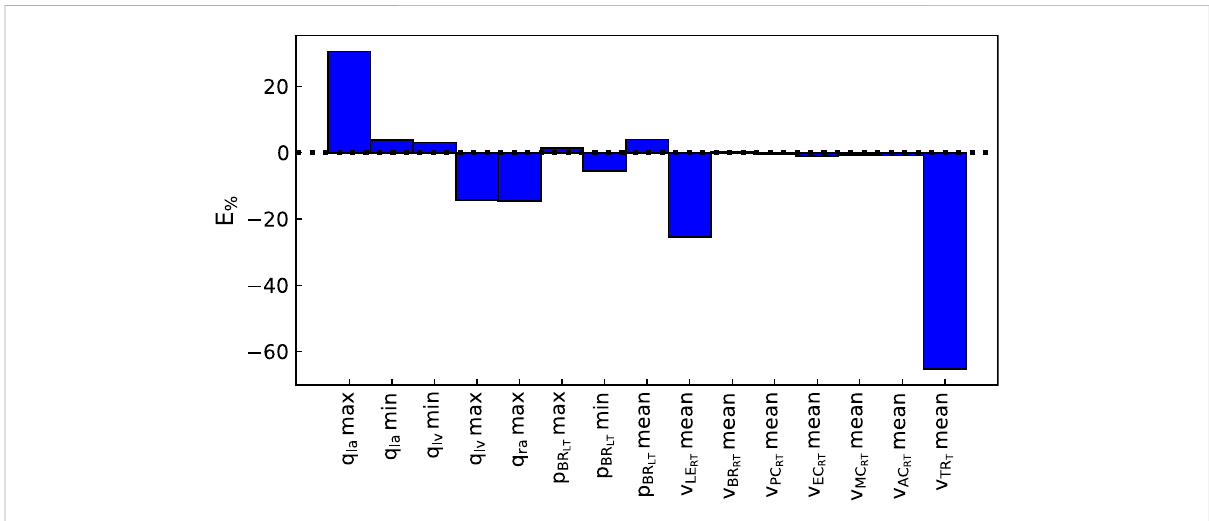
FIGURE 3 Percentage error between optimal model outputs ( f i ( θ )) and measured data ( ^ z i ) from the parameter identi fi cation pipeline for Patient 1 (normalised by ^ z i ). q la : left atrium volume, q lv : left ventricle volume, q ra : right atrium volume, p BR L : left brachial pressure, v LE RT : right leg terminal fl ow, fl ow, v PC fl ow, v EC fl ow, v MC v BR RT : right brachial terminal RT : right posterior cerebral terminal RT : right external carotid terminal RT : right middle cerebral terminal fl ow, v AC RT : right anterior cerebral terminal fl ow, v TR T : trunk terminal fl ow.